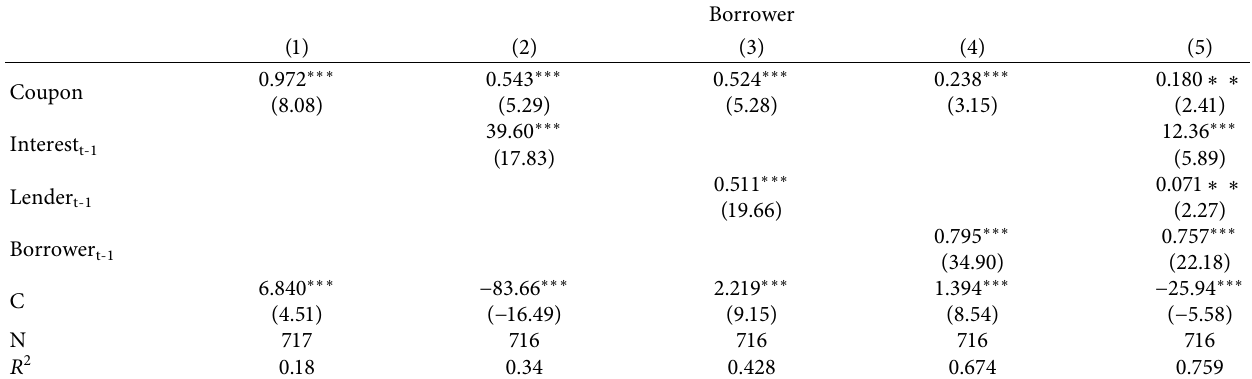
Table 10: The influence of coupon strategy on the number of